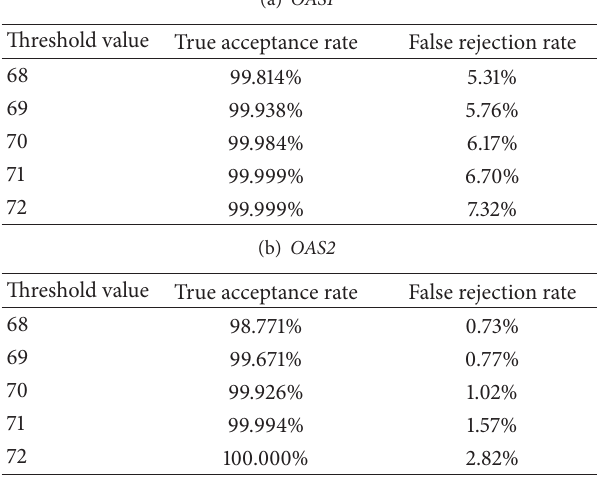
Table 1: The true acceptance rates and false rejection rates with different threshold